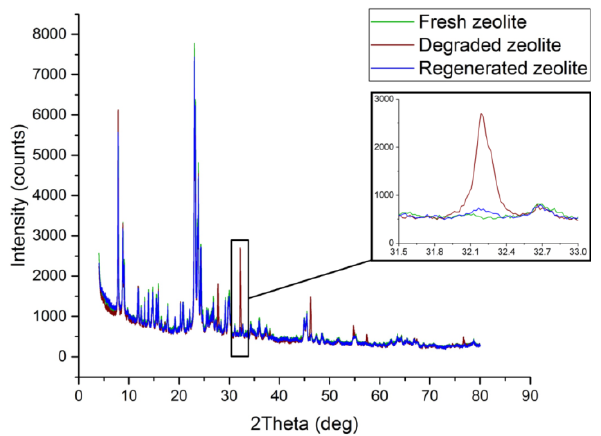
Figure 7. XRD patterns of fresh ( green ), degraded ( red ), and regenerated ( blue ) zeolite samples; (insert) zoom on the range 31.5–33° to highlight one peak of the AgCl Chlorargyrite CFC (PDF 85-1355).